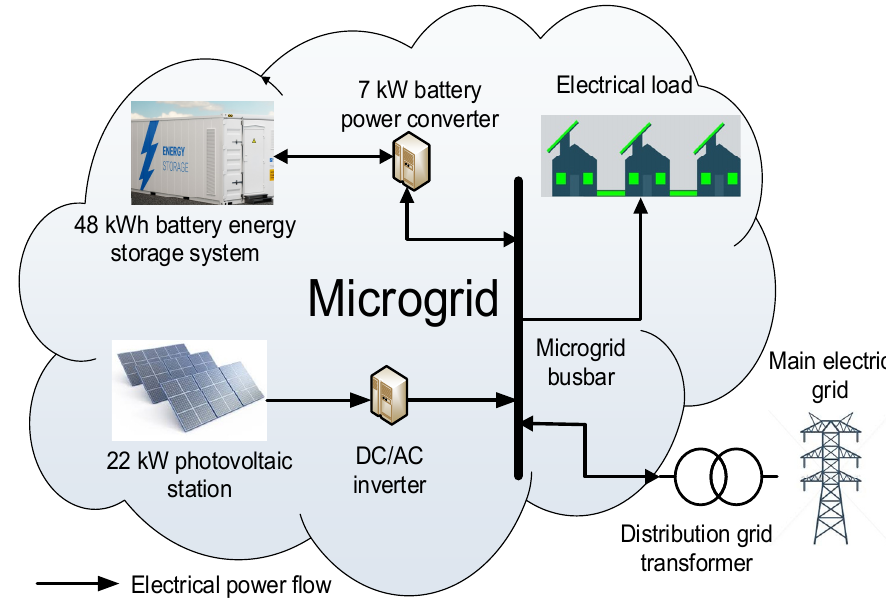
Figure 2. Simplified representation of the microgrid architecture.